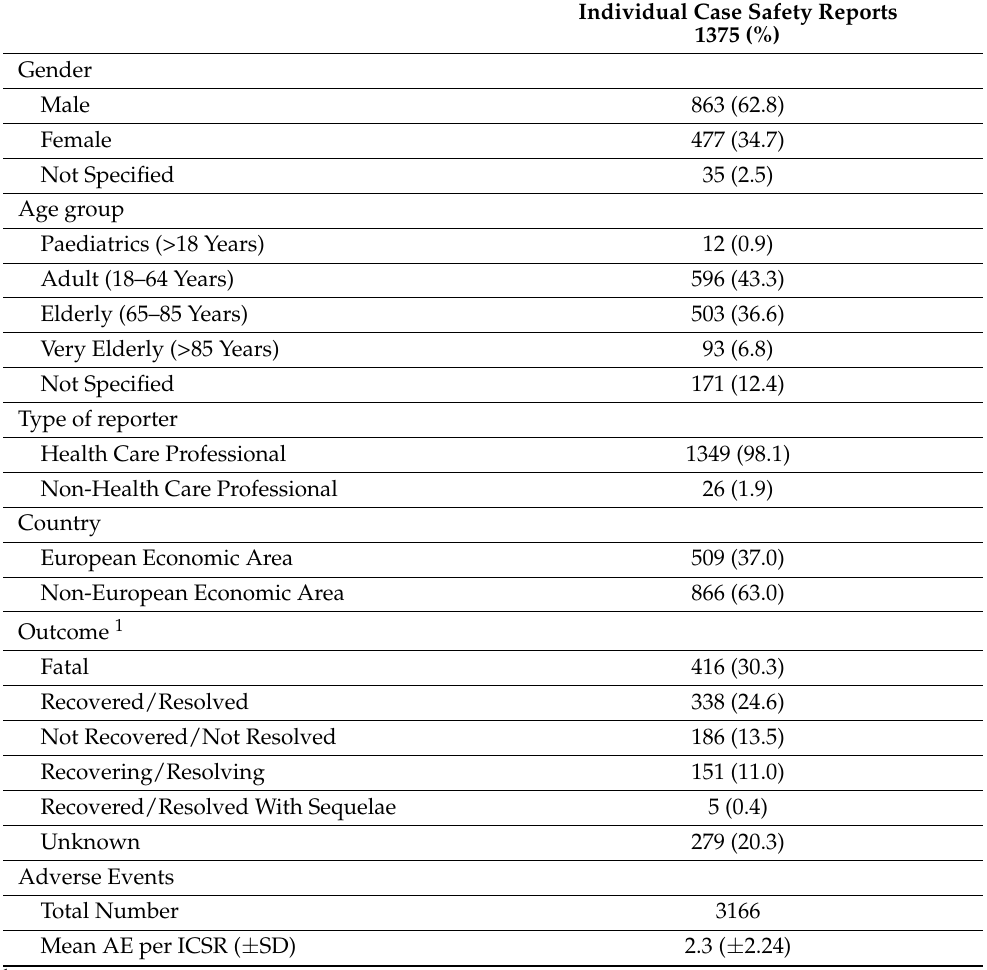
Table 1. Demographic characteristics of Individual Case Safety Reports (ICSRs) involving remdesivir